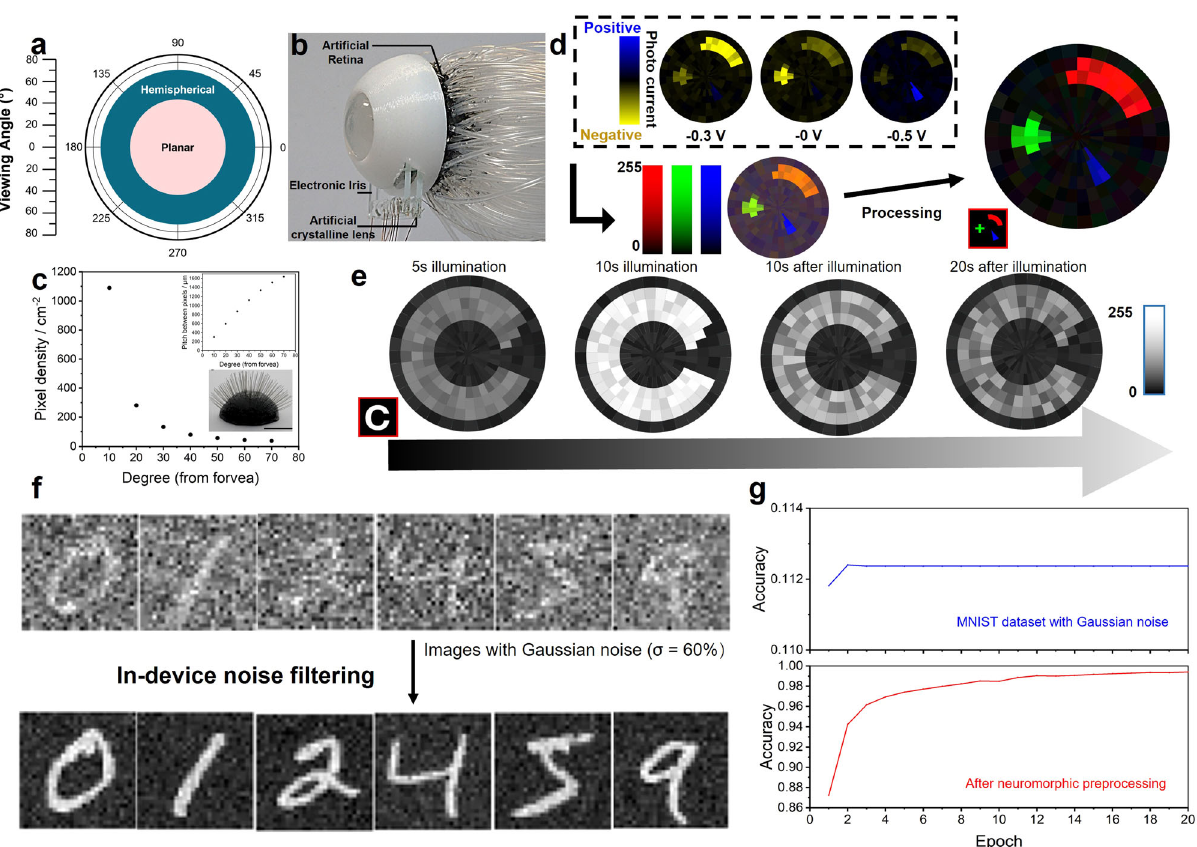
Fig. 4 | Characterization and neuromorphic image sensing demonstration of thebioniceye.a Viewingangleofthehemisphericalandplanardevices. b Photoof the bionic eye device. c Area dependent pixel density distribution of the arti fi cial retina. The inset fi gures show the pixels ’ pitch distribution (up) and a photo of Ni microwire electrodes aligned on the hemispherical retina, with a scale bar of ‘ 1cm (down). d Demonstration of color pattern reconstruction. Including three current maps measured with different biases, reconstructed images before and